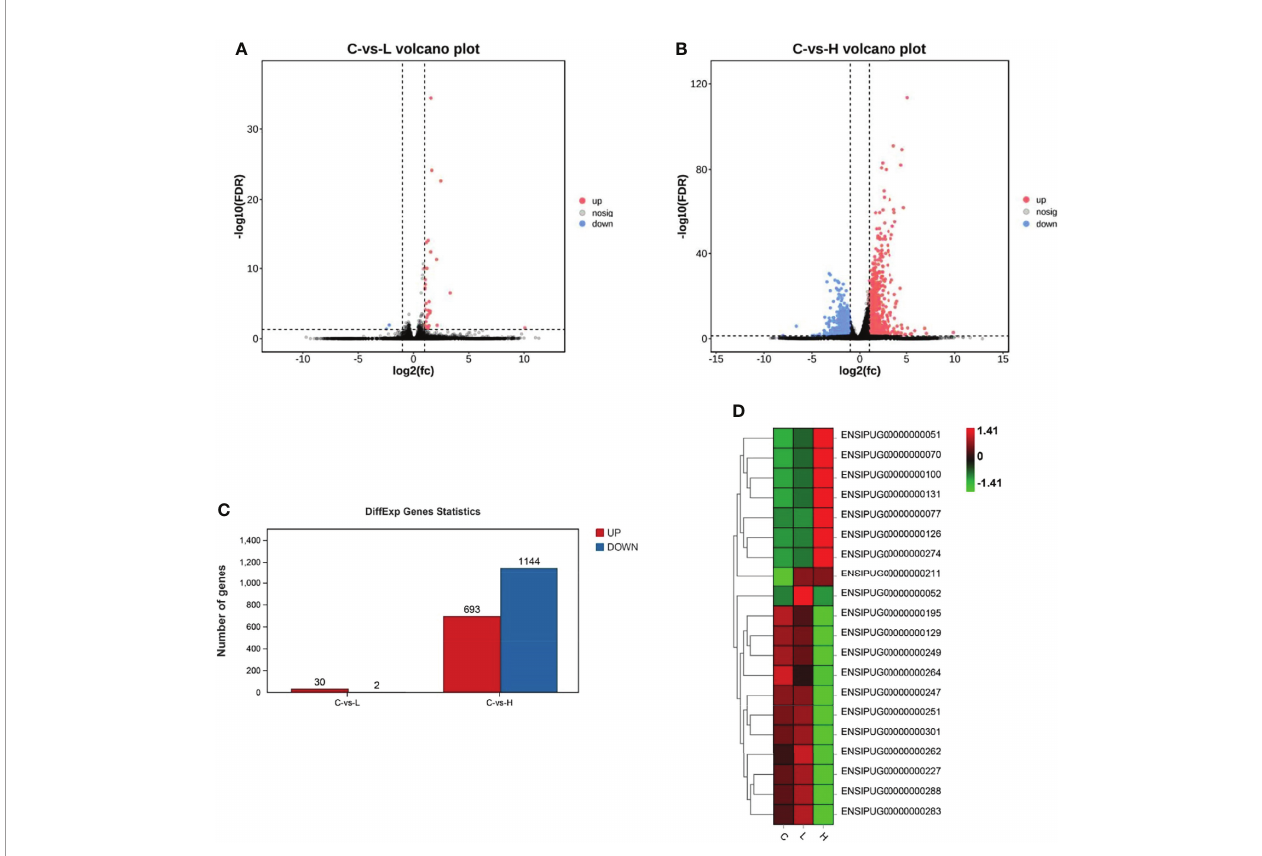
FIGURE 2 | Summary of differentially expressed genes (DEGs) in channel cat fi sh after exposure to 0.5 and 5 m g/L Del. Volcano plots of DEGs in the trunk kidney treated with (A) 0.5 and (B) 5 m g/L Del. Red and blue dots indicate upregulated and downregulated genes, respectively. (C) Statistical results of DEGs in the C (control) vs L (0.5 m g/L), and C (control) vs H (5 m g/L) group comparisons; (D) Heat map of gene expression